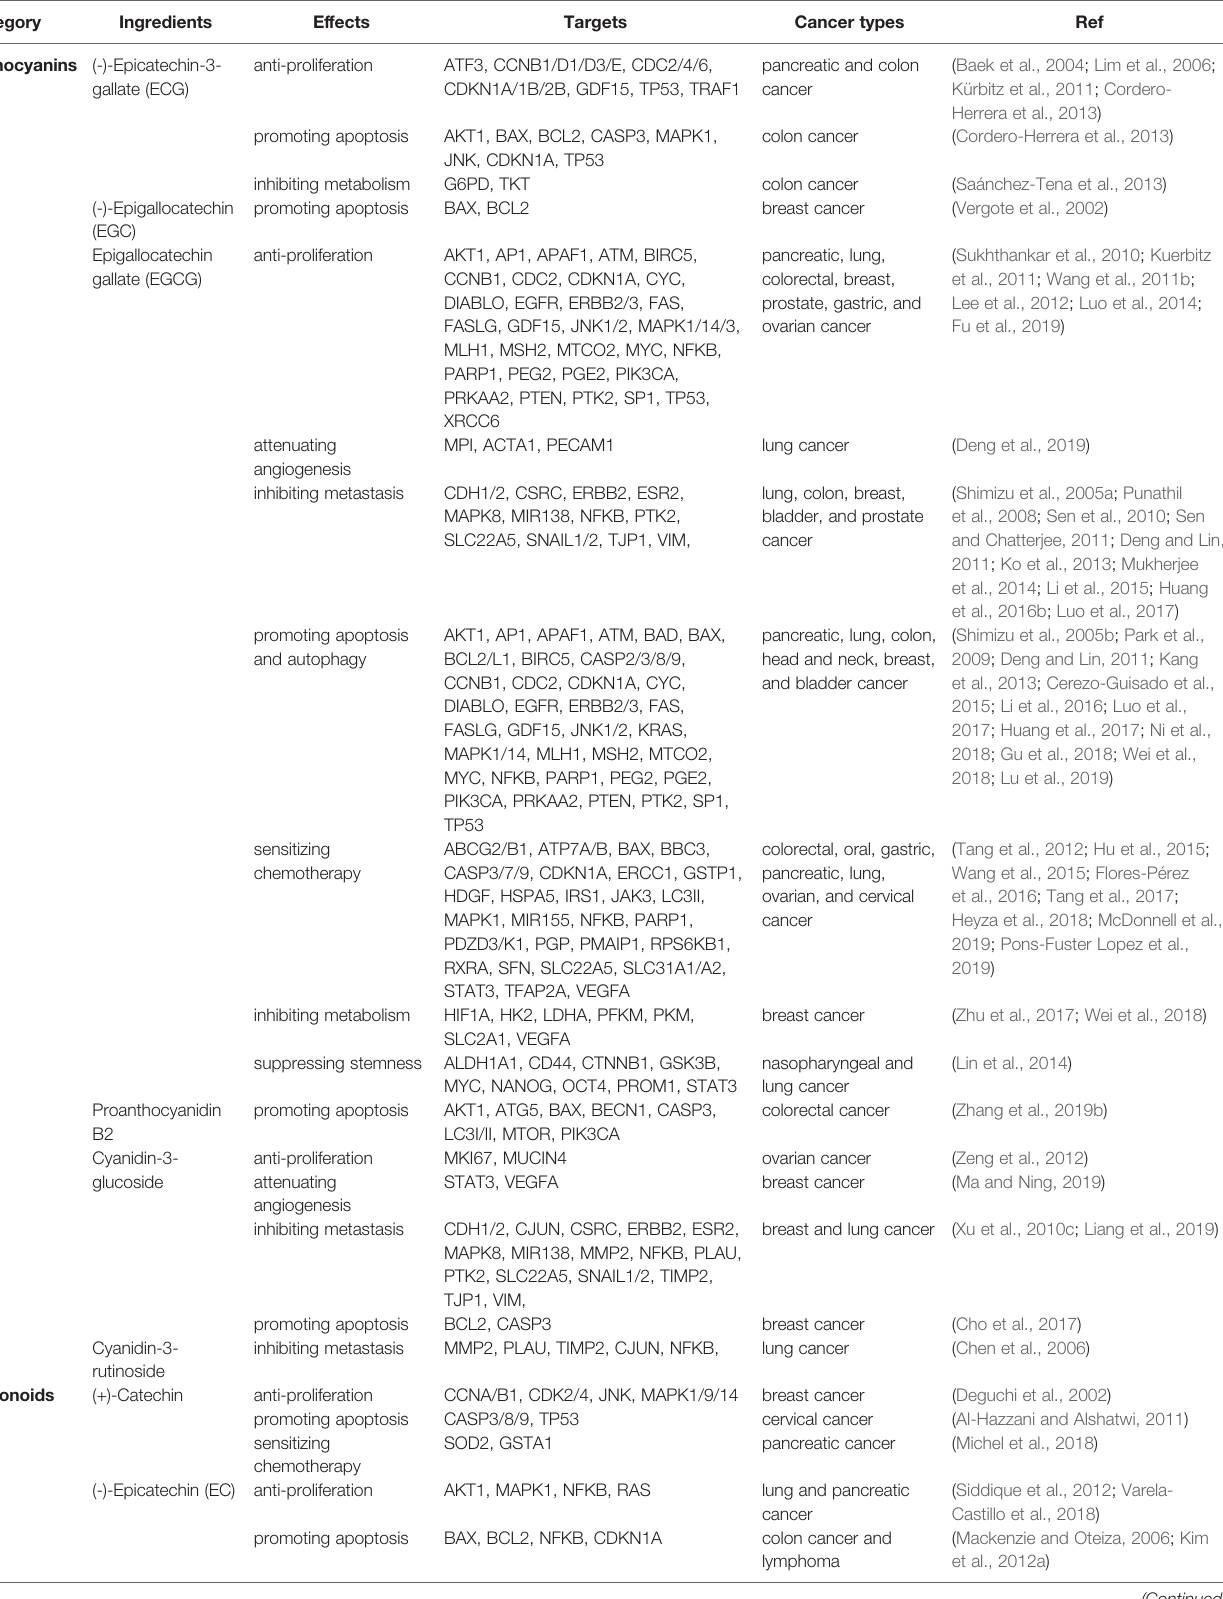
TABLE 2 | The Anticancer Ingredients and Targets from